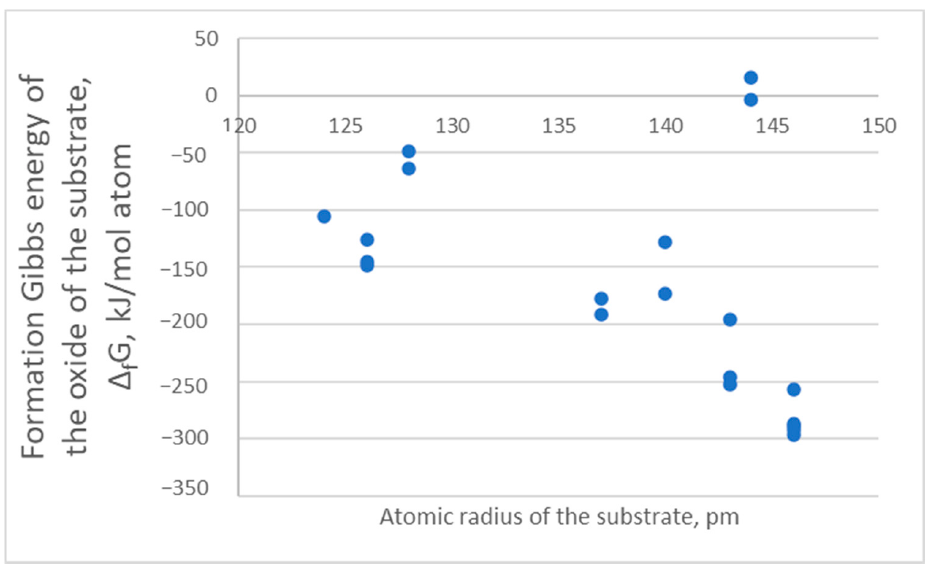
Figure 5. Free enthalpy of the formation of oxides [37] as a function of the atomic radius of the substrate.